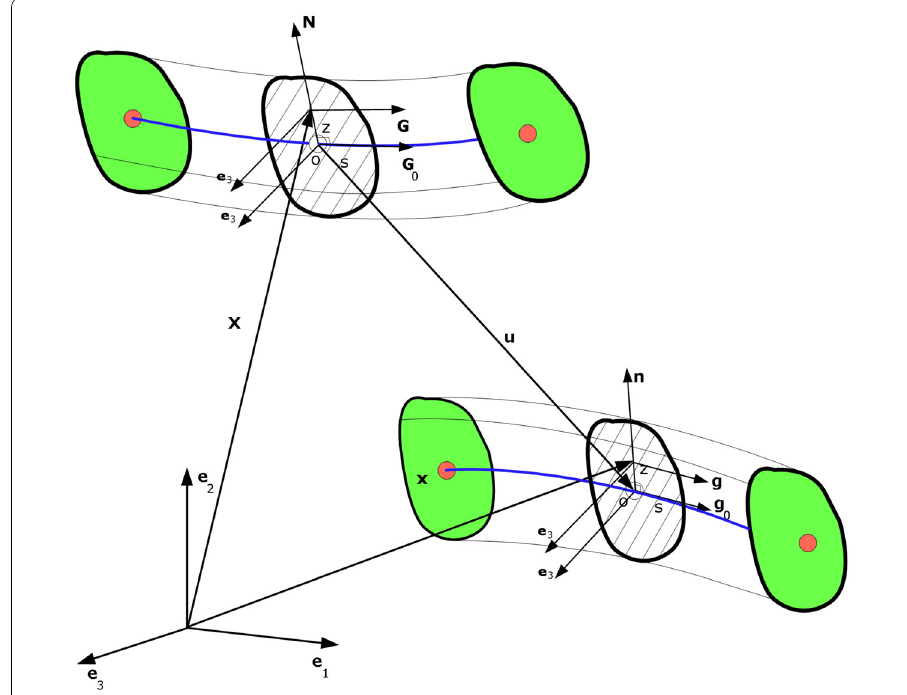
Fig. 1 Kinematic of beam